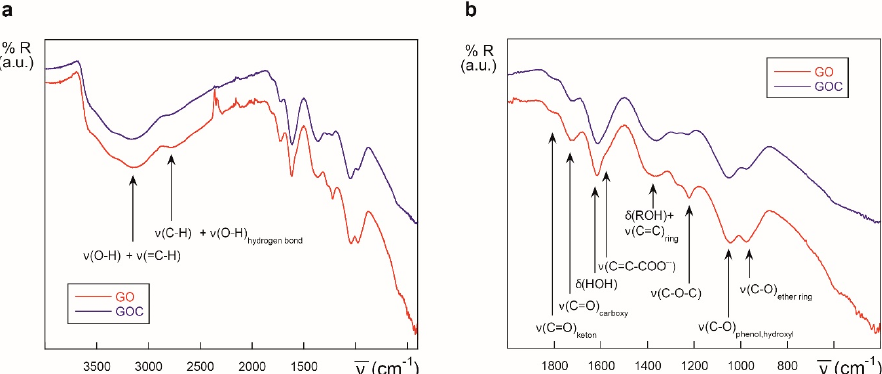
Figure 2. ATR-IR spectra of different graphene derivatives: GO (red) and GOC (blue), in the 4000 ‒ 400 cm ‒ 1 ( a ) and 2000 ‒ 400 cm ‒ 1 regions ( b ).